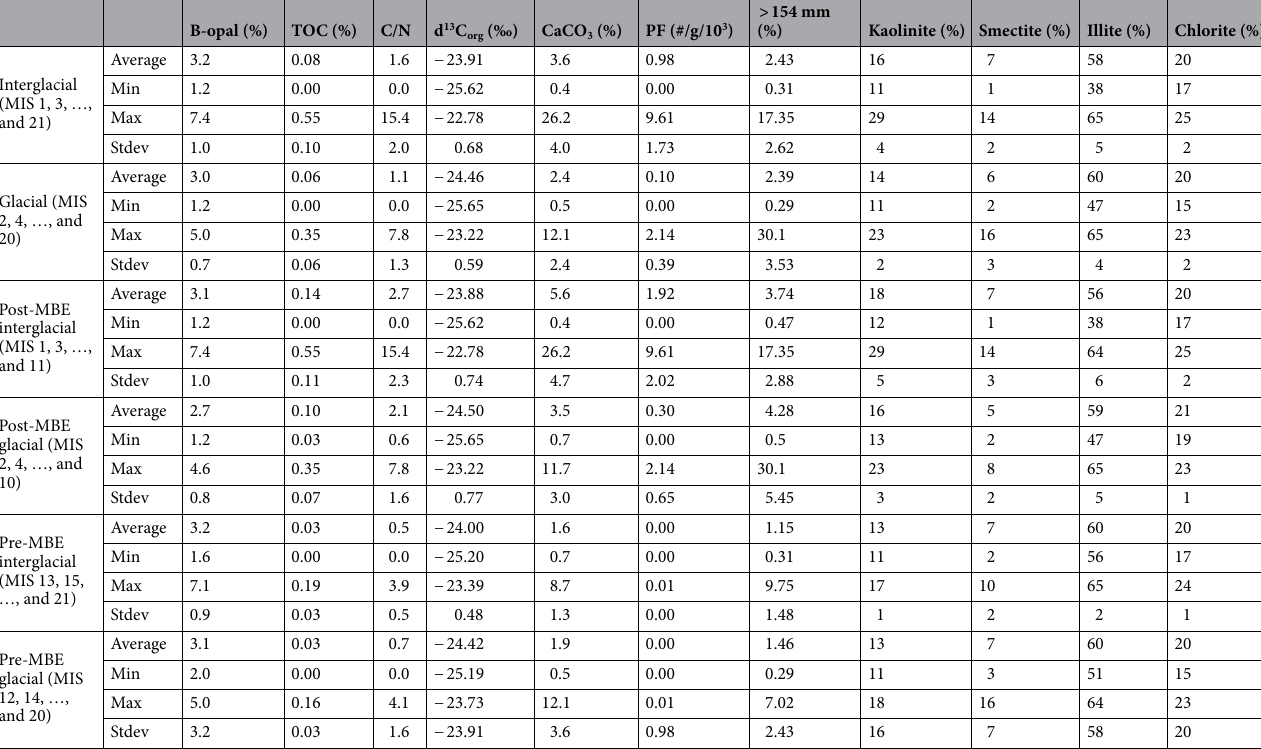
Table 2. Statistical summary of geochemical and mineralogical results of MA01 for interglacial and glacial periods during the last ~ 840 kyrs and post-MBE (after 424 ka) and pre-MBE (before 424 ka).